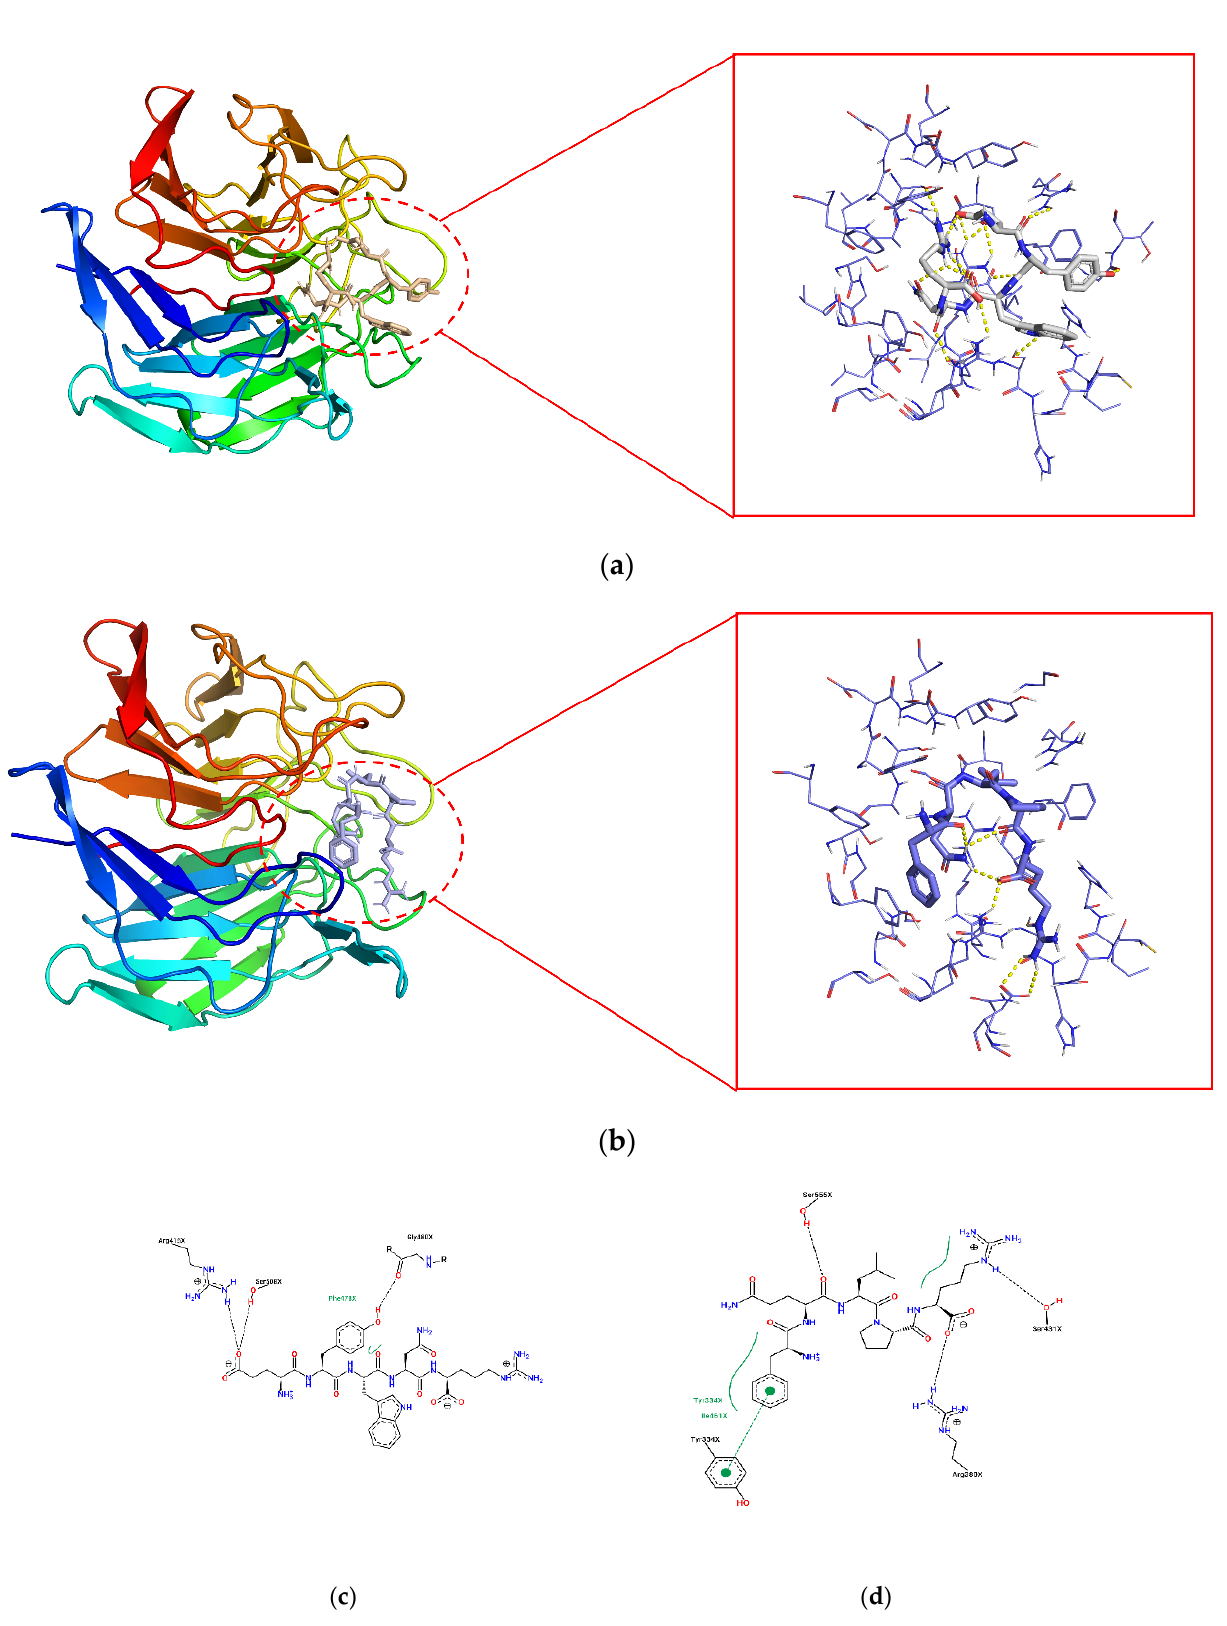
Figure 4. The 2D and 3D molecular interactions of P2 ( a , c ) and P6 ( b , d ) with the Keap1 active site (PDB ID: 6FLU). P2, EYWNR; p6, FQLPR.